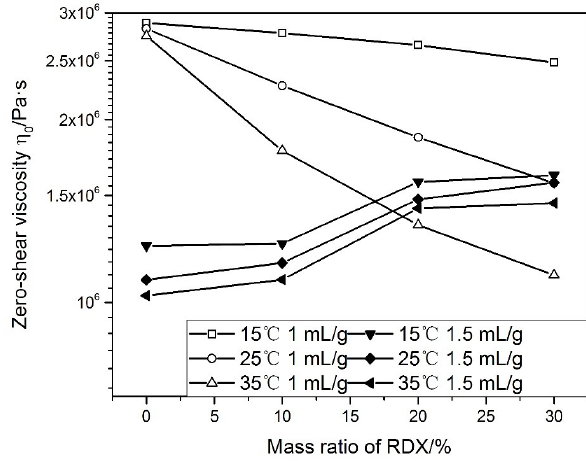
Figure 4: ZSV vs. mass ratio for RDX at different temperatures.